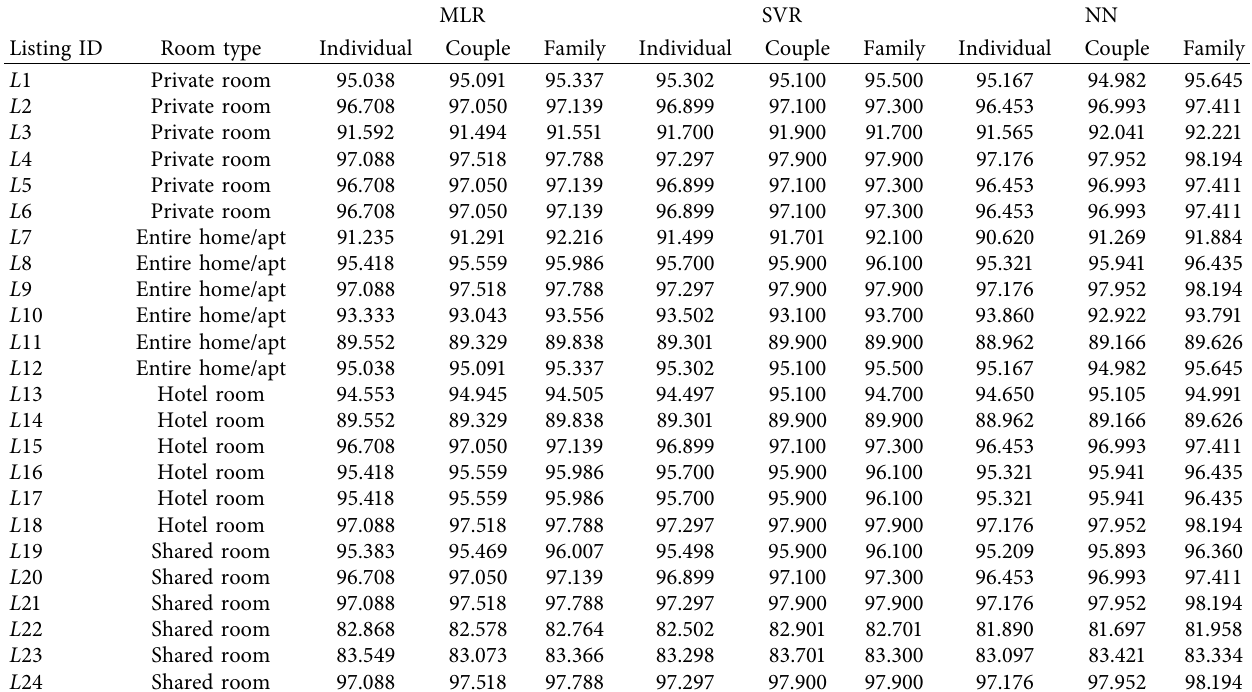
Table 4: Overall scores predicted on the basis of real elementary scores on a sample of 24 listings according to the category of customers using MLR, SVR, and NN